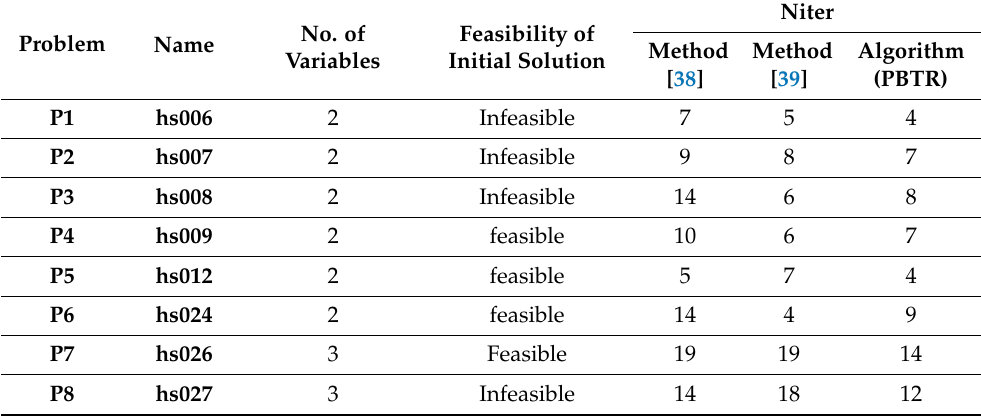
Table 1. Comparison of methods in [38,39] with PBTR